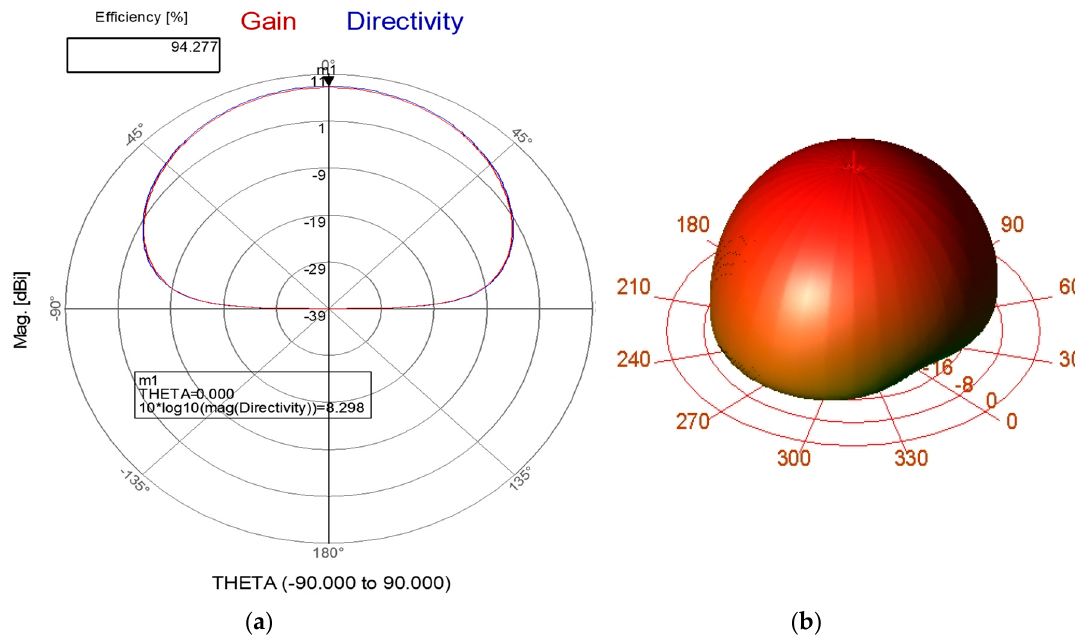
Figure 23. ( a ) Radiation pattern of the Double Layer Circular microstrip antenna with CSRR at 2.7 GHz. ( b ) 3D radiation pattern of the Double Layer Circular patch antenna with CSRR.